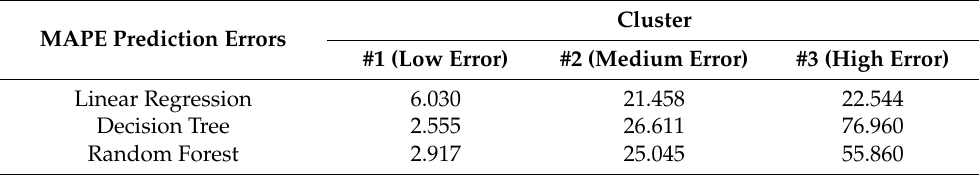
Table 5. Final cluster centers.